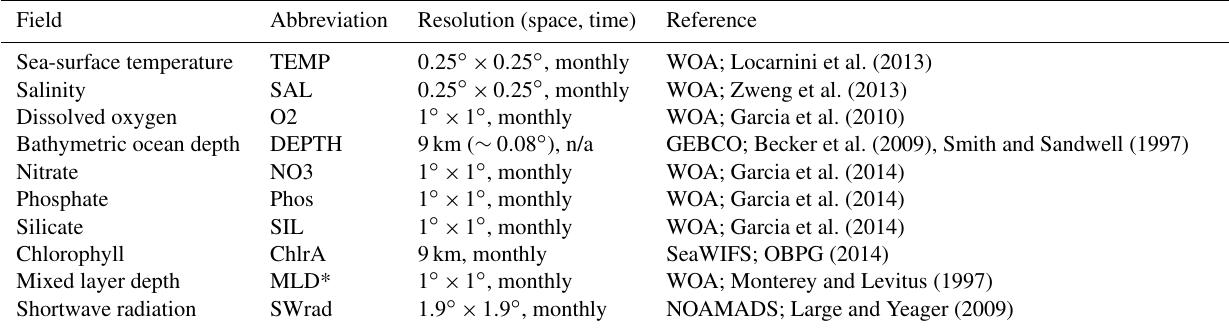
Table 1. Ancillary variables extracted onto a global 0 . 125 ◦ × 0 . 125 ◦ ( ∼ 12 . 5km × 12 . 5km) grid on a monthly basis.